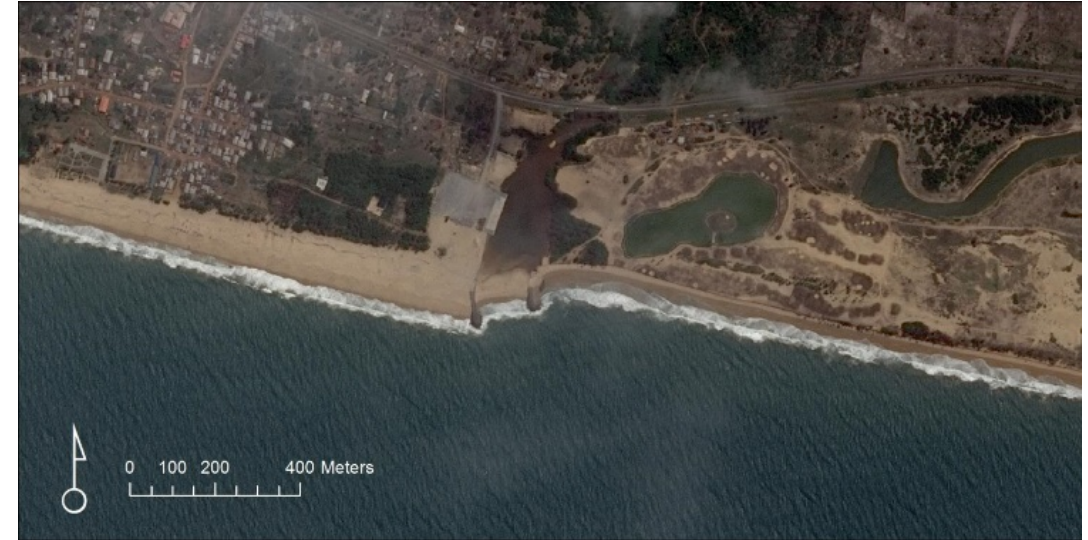
Figure A1. Lekki coast, January 2015.